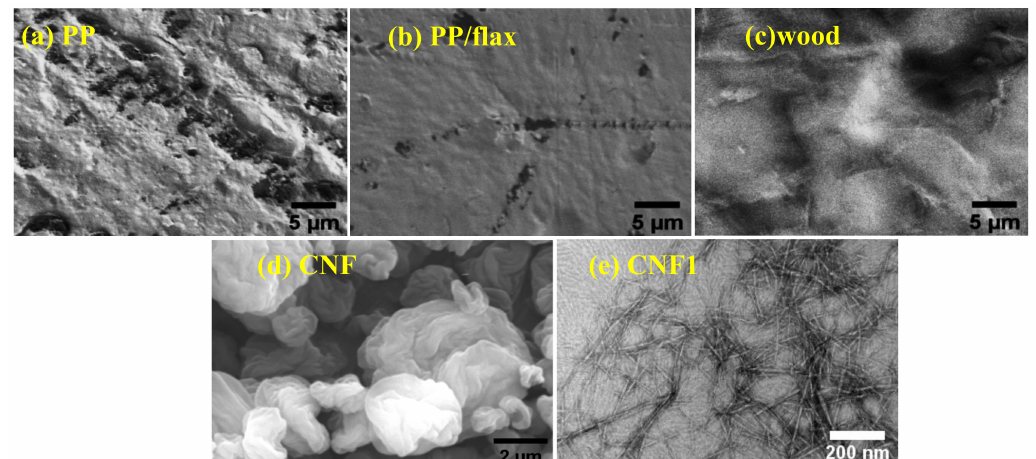
Figure 2. Surface morphology of the coatings formed on various substrates obtained through FE-SEM., ( a ) Polypropylene Homopolymer (PP) ( b ) PP/flax ( c ) wood ( d ) nano-fibrillated cellulose (CNF) ( e ) CNF1.